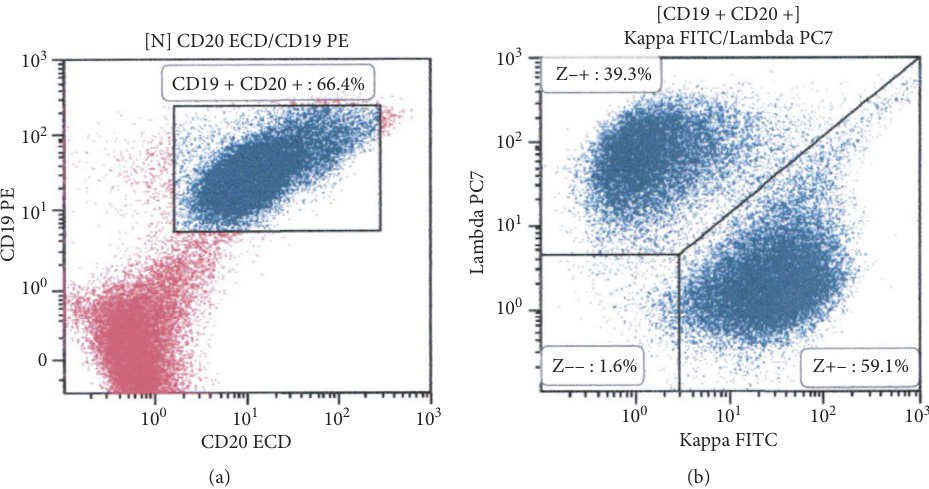
Figure 5: Flow cytometry analysis results. We used an endoscopic biopsy specimen for flow cytometry analysis; light chain restriction was not observed. CD19 + and CD20 + cells are gated (a), and light chain expression analysis reveals an almost equal number of Ig κ - and Ig λ -producing cells